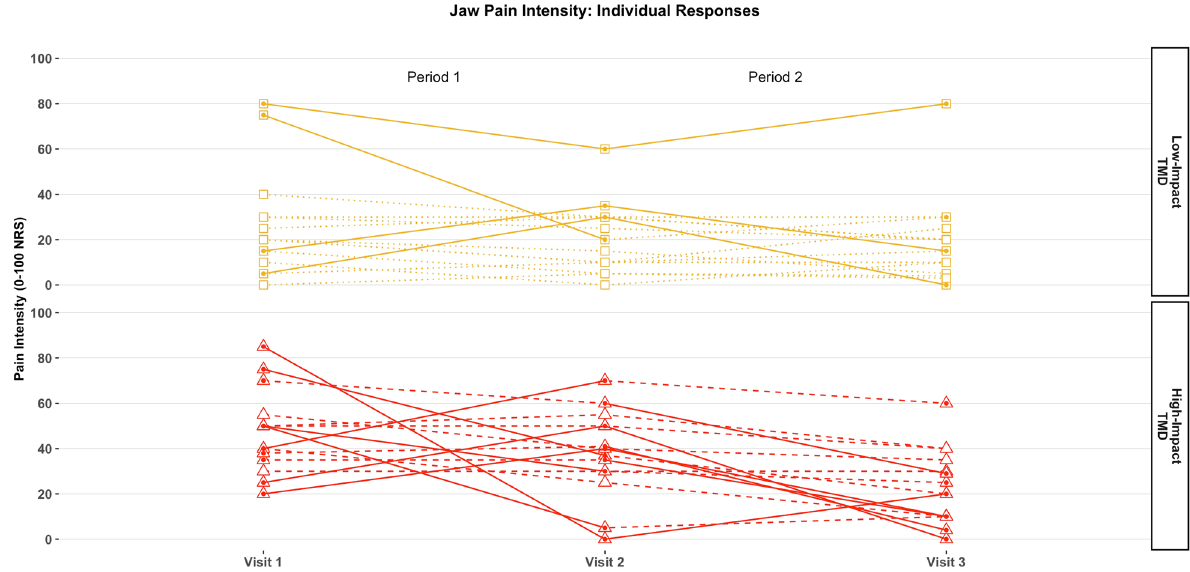
Figure 1. Current jaw pain intensity over time: individual responses. Dotted symbols and solid lines in either one or both periods identify participants who presented with pain fluctuations, defined as jaw pain rating difference ≥ 20 (0–100 NRS) between visit 1 and visit 2 (period 1) or between visit 2 and visit 3 (period 2). Empty symbols and dashed lines in both periods identify participants with no such pain